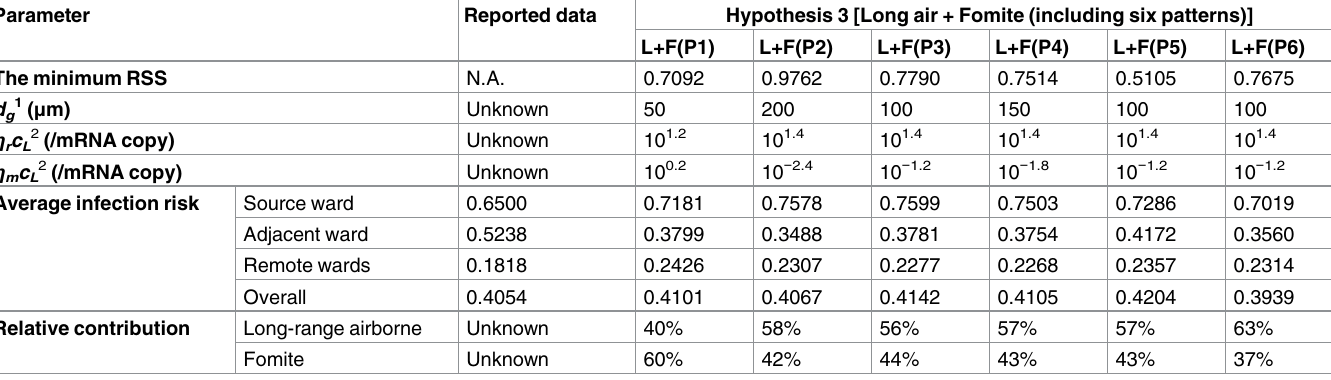
Table 2. Important parameters for scenarios with the minimum RSS for Hypothesis 3 [Long air + Fomite (including six patterns)].